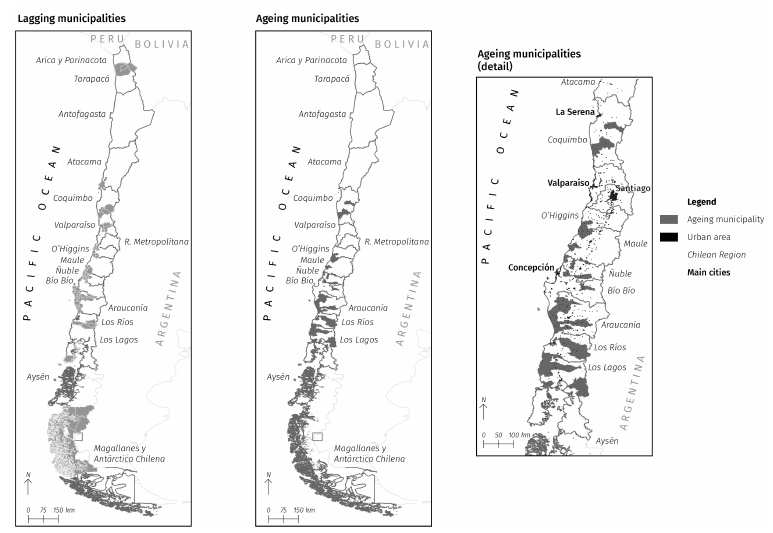
Figure 1: Lagging and ageing municipalities in